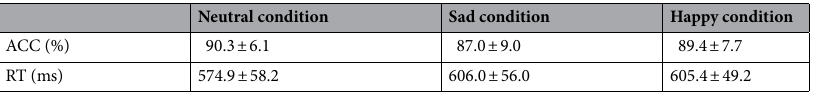
Table 1. RT and ACC in the three conditions in EST (mean ± SD, n = 32).